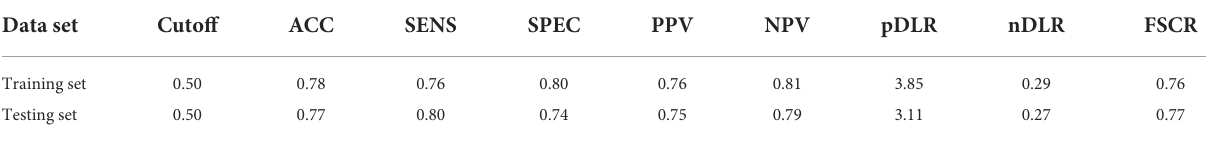
TABLE 3 Parameters of ROC curves for prediction of infectious diseases in training set and testing set. Data